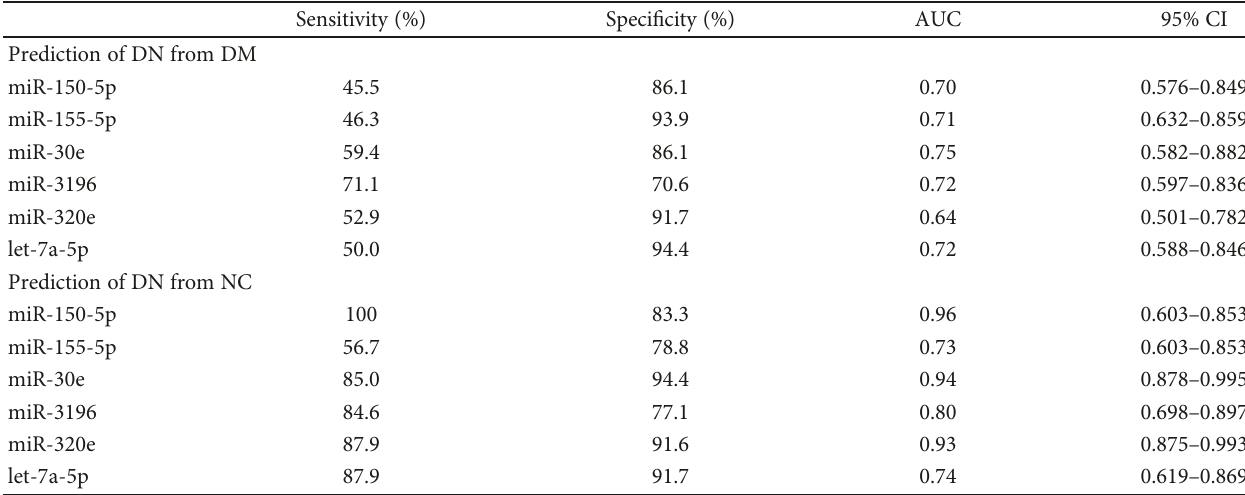
Table 3: Diagnostic value of plasma miRNAs for